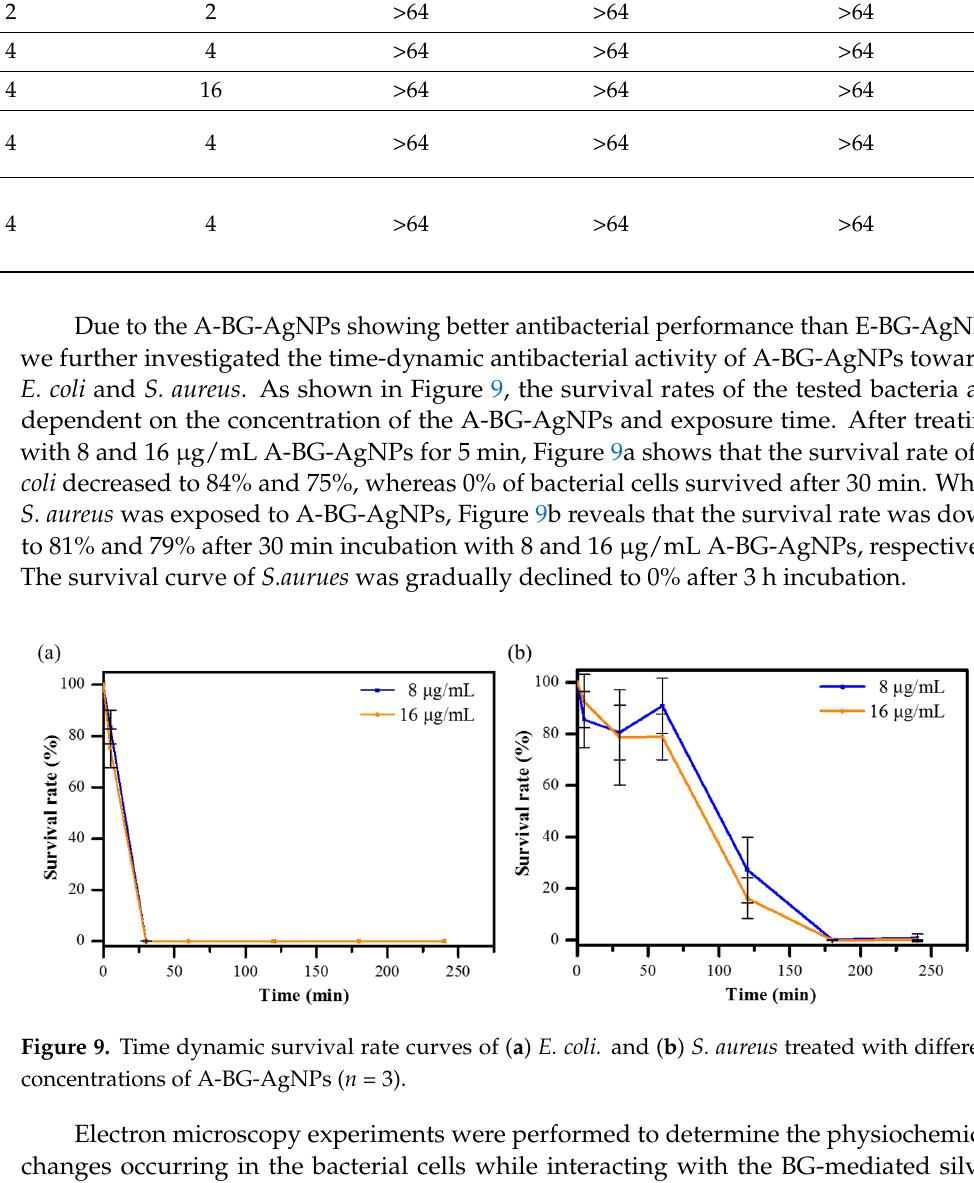
Figure 10. TEM ( a – c ) and SEM ( d – f ) images of E. coli with and without treatment with AgNPs (20 µg/mL). The E. coli cells were treated with ( a , d ) A-BG-AgNPs and ( b , e ) E-BG-AgNPs, and ( c , f ) show untreated bacteria cells. We further performed the TEM measurements to evaluate the structural changes of S. aureus and A. baumannii while adding BG-AgNPs. While S. aureus was incubating with BG-AgNPs (32 µg/mL), bacterial cells failed to retain their original shapes (Figure 11a,b)